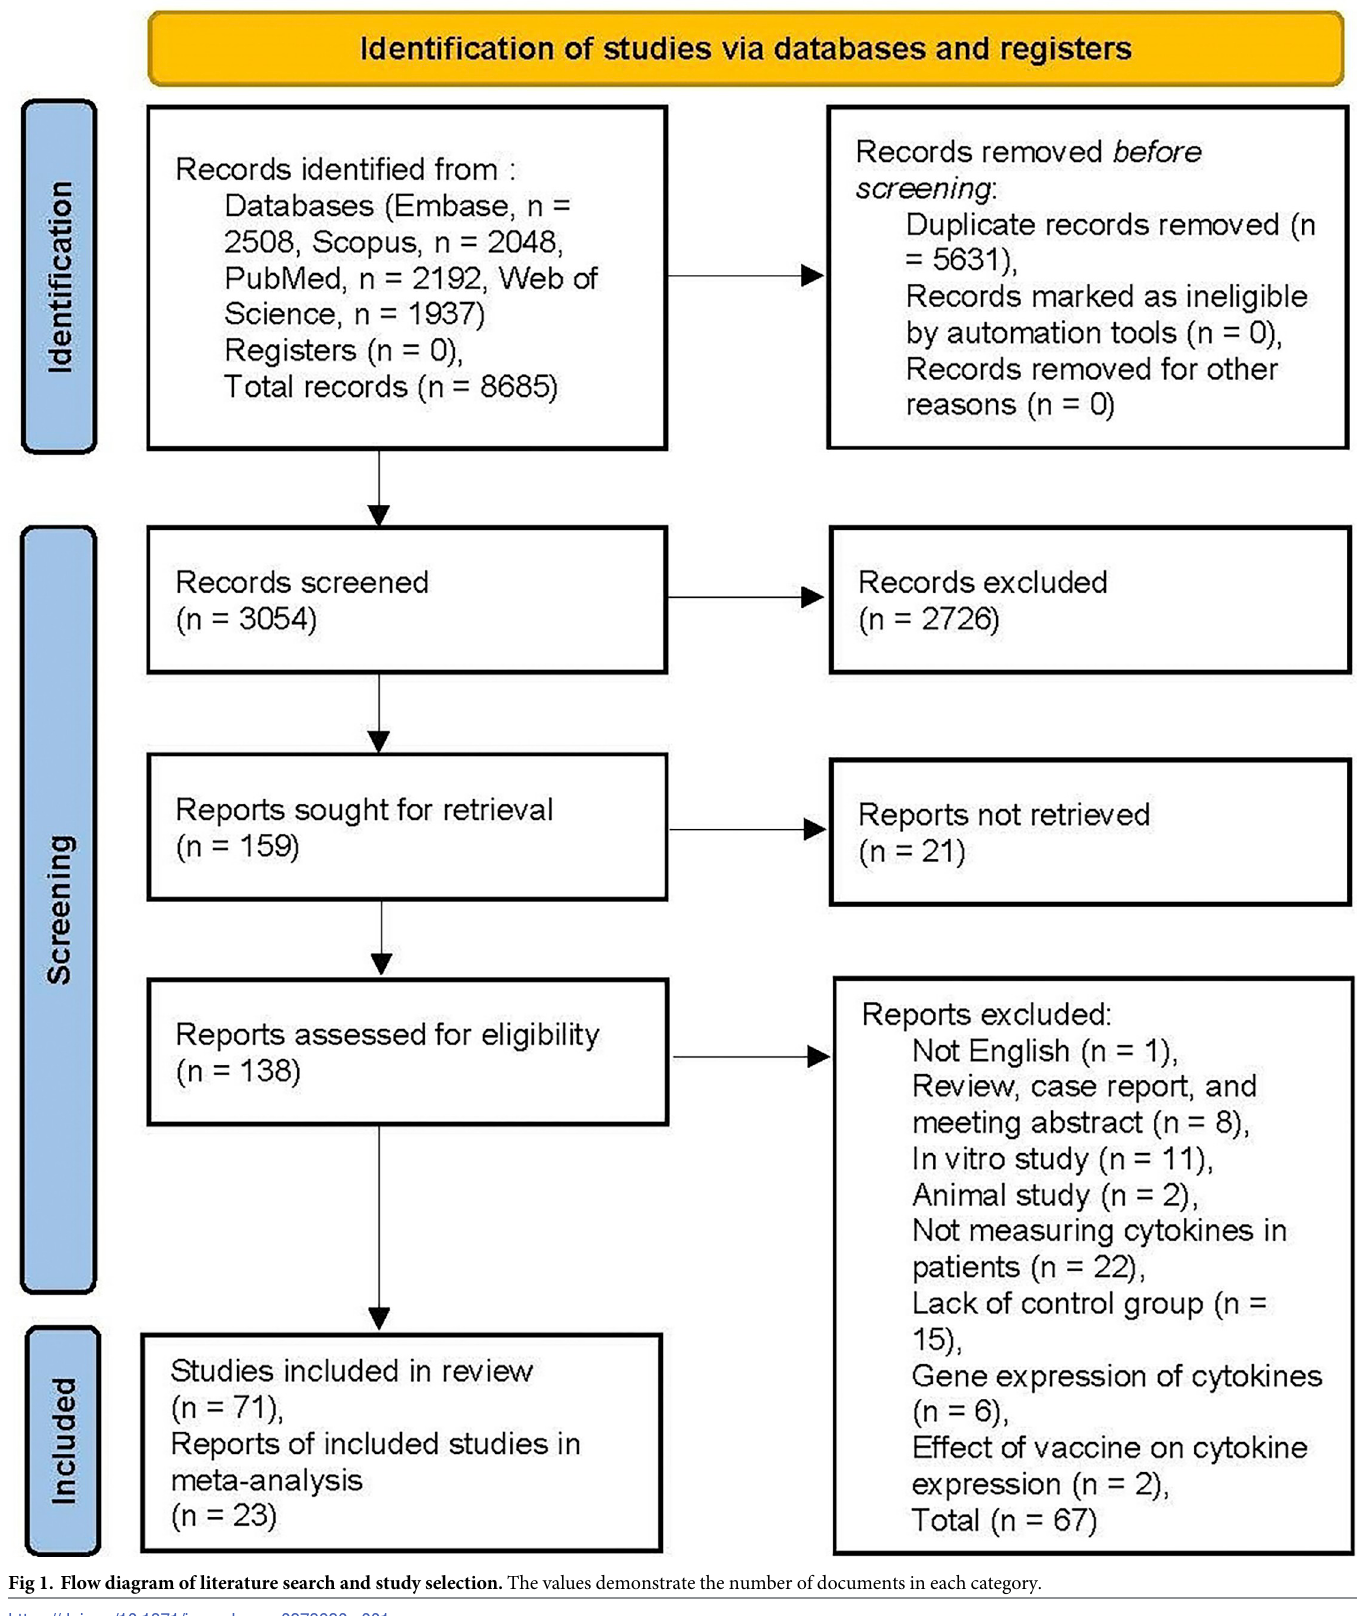
Fig 1. Flow diagram of literature search and study selection. The values demonstrate the number of documents in each category. https://doi.org/10.1371/journal.pone.0273920.g001 PLOS ONE | https://doi.org/10.1371/journal.pone.0273920 September 1,